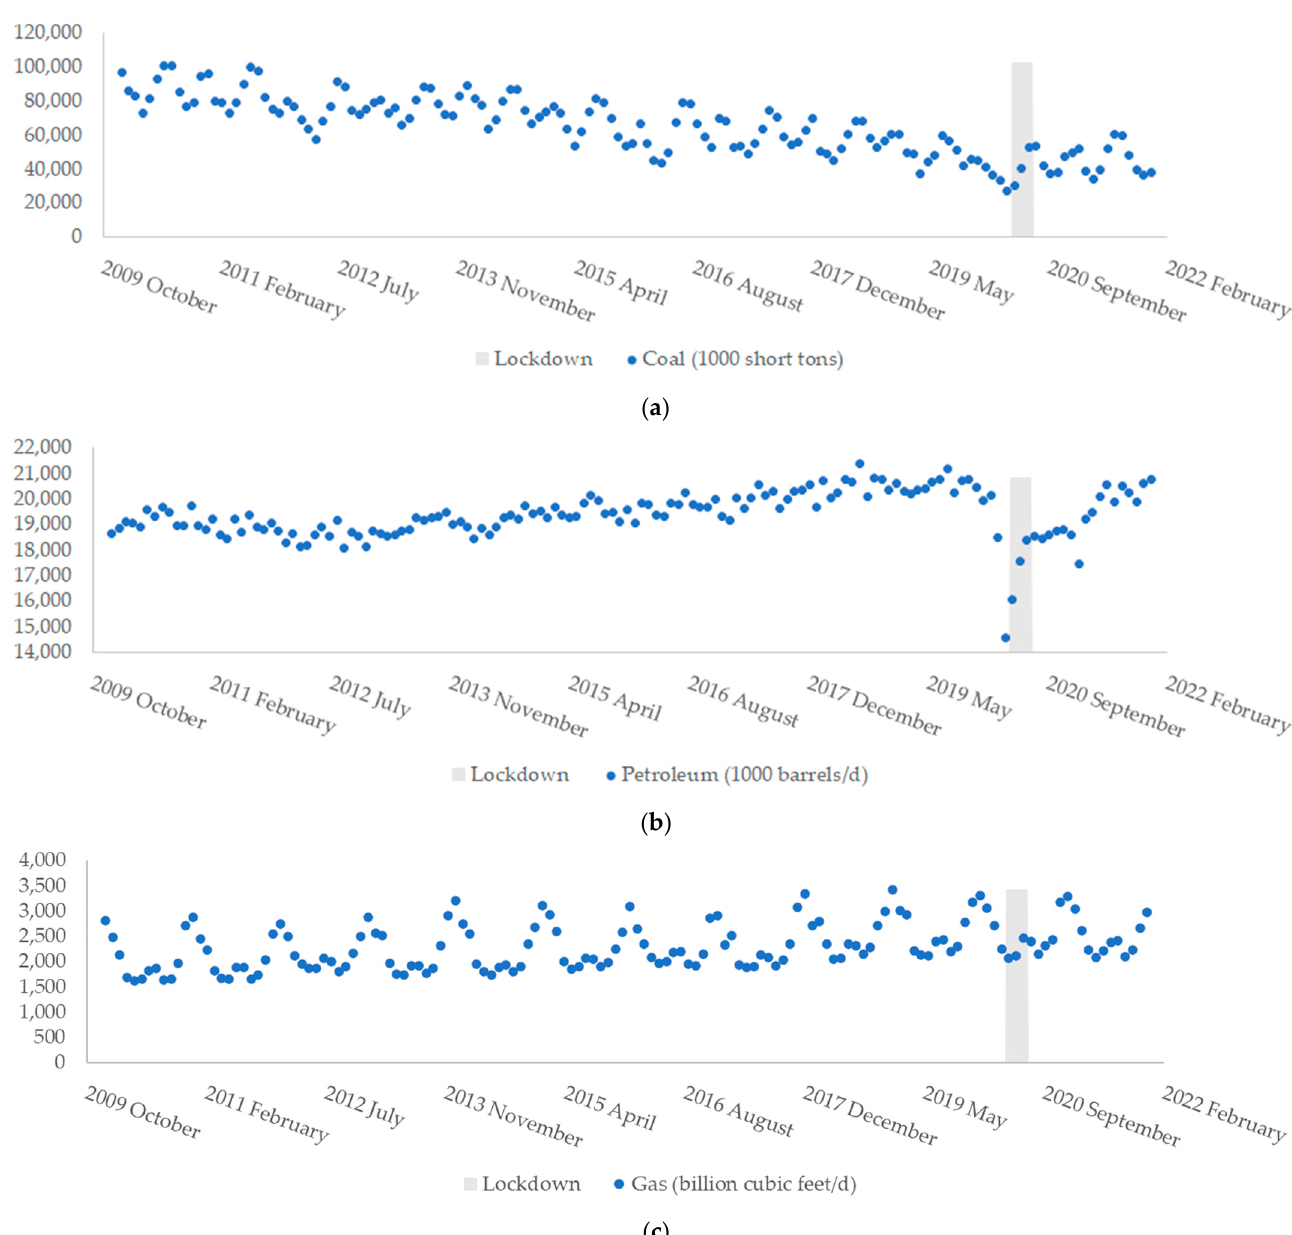
Figure 11. US historic energy consumption by fossil fuel type: ( a ) coal; ( b ) petroleum; ( c ) natural gas [33].